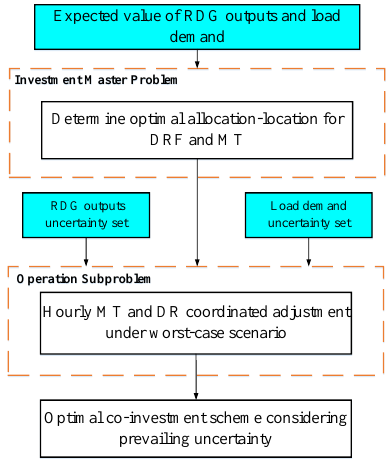
Figure 1. Two-stage, robust co-planning framework.